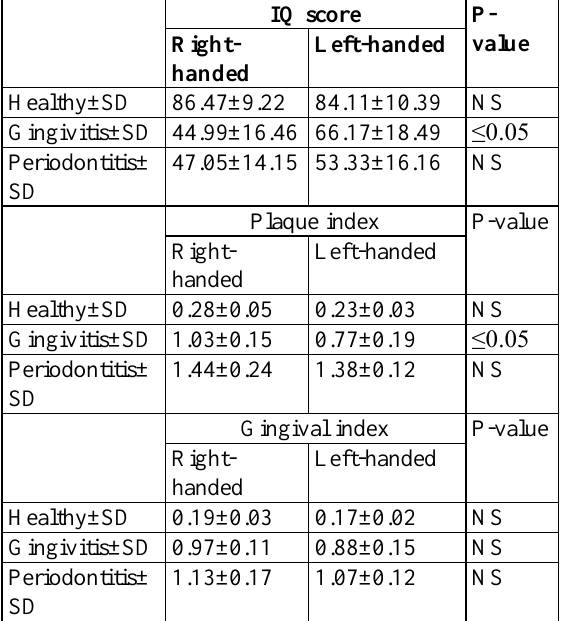
Table 1: Comparison of IQ, PLI, and GI between right- and left-handed groups